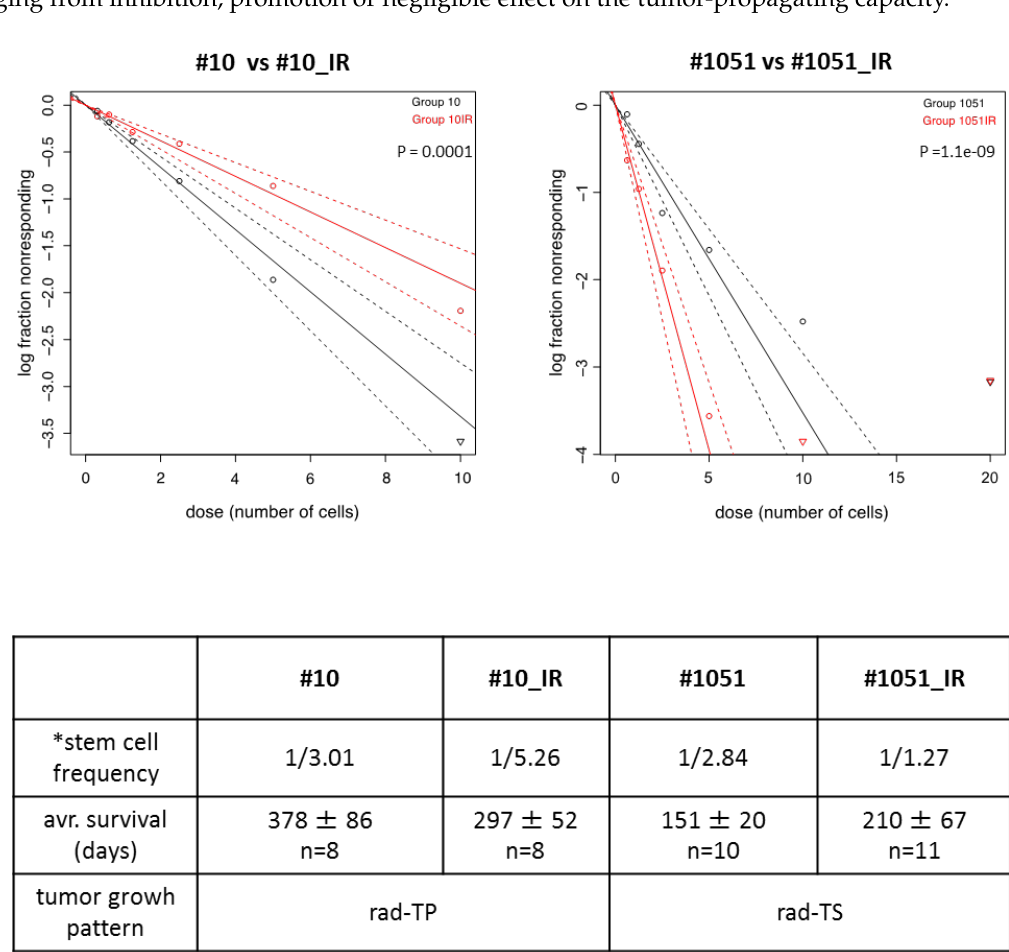
Figure 8. Comparative assessments of self-renewal in non-radiated and radiated GSCs by ELDA. Upper panels show the results for #10 / #10_IR or #1051 / #1051_IR pairs from three independent experiments. Table shows average frequency of stem cells (*) determined in three independent experiments. Also shown are average survival time of mice implanted with corresponding GSCs and tumor growth pattern after radiation.